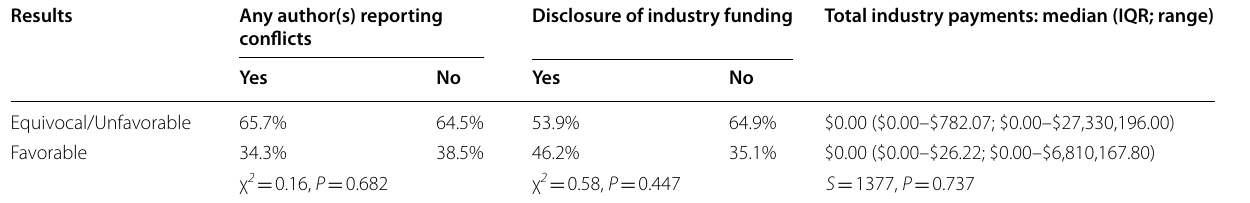
Table 1 Effects of conflicts of interest and industry funding on study results Results